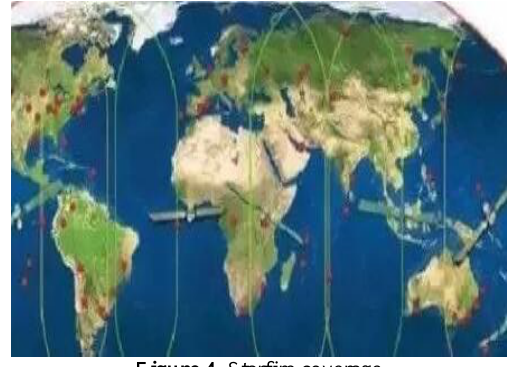
Figure 4. Starfire coverage